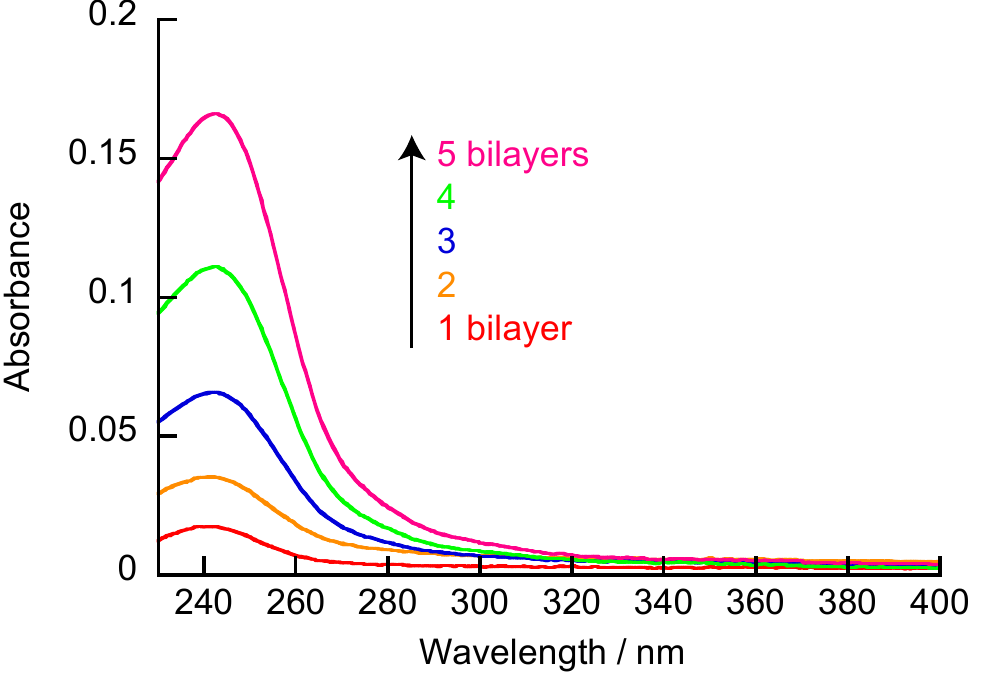
Figure 5. UV-vis absorption spectra for the preparation of (PBA-PAMAM/PVA) 5 films.